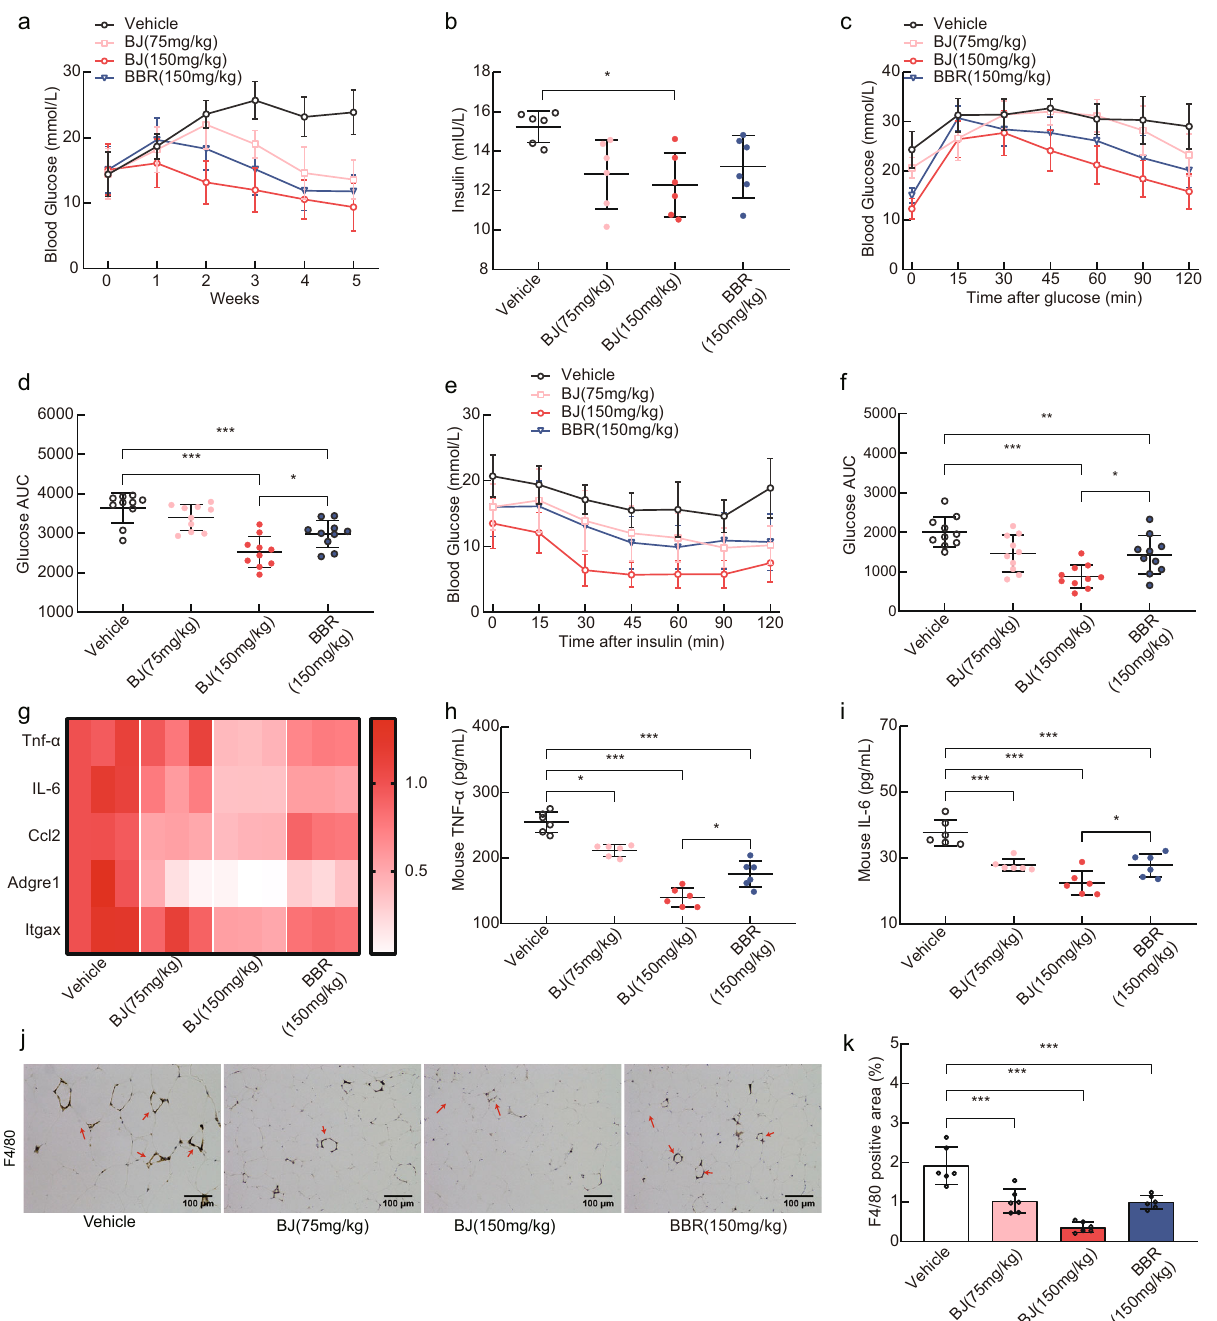
Fig. 5 BJ regulates blood glucose levels, enhances insulin sensitivity and inhibits in fl ammation of eWAT in db/db mice. a Weekly fasting glucose levels of db/db mice ( n = 6 per group). b Fasting serum insulin levels in db/db mice after 35 days of treatment ( n = 6 per group). c , d GTT and the area under the curve (AUC) ( n = 6 per group). e , f ITT and the AUC ( n = 6 per group). g Heat map of in fl ammatory related genes and macrophage marker genes in eWAT of db/db mice. h , i Serum levels of TNF- α and IL-6 in db/db mice ( n = 6 per group). j Immunohistochemical staining of the eWAT for F4/80 (scale bar = 100 µ m). k Quanti fi cation of immunohistochemical staining as a percentage of positive area ( n = 6). Data are expressed as mean ± SD. NS not signi fi cant, * P < 0.05, ** P < 0.01, *** P < BJ inhibits lipid accumulation and in fl ammation in 3T3-L1 adipocytes in a dose-dependent manner (Fig. 7a, b). Staining with adipocytes . Meanwhile, we conducted in vitro experiments to MitoTracker red and an anti-UCP1 antibody indicated that the validate the role of BJ in adipocytes. BJ (3 μ M and 10 μ M) or BBR mitochondrial mass of 3T3-L1 adipocytes treated with BJ was more (10 μ M) was added on day 8 during the differentiation of 3T3-L1 signi fi cant, and the expression of the UCP1 protein was sig- adipocytes and incubated for 24 h to evaluate the inhibitory effect ni fi cantly increased (Fig. 7c, d). Furthermore, compared with the of BJ on lipid accumulation. Compared with control differentiated same dose of BBR, the effect of BJ was more signi fi cant. These fi ndings were similar to the results in vivo. adipocytes, BJ reduced the accumulation of lipid droplets in 3T3-L1